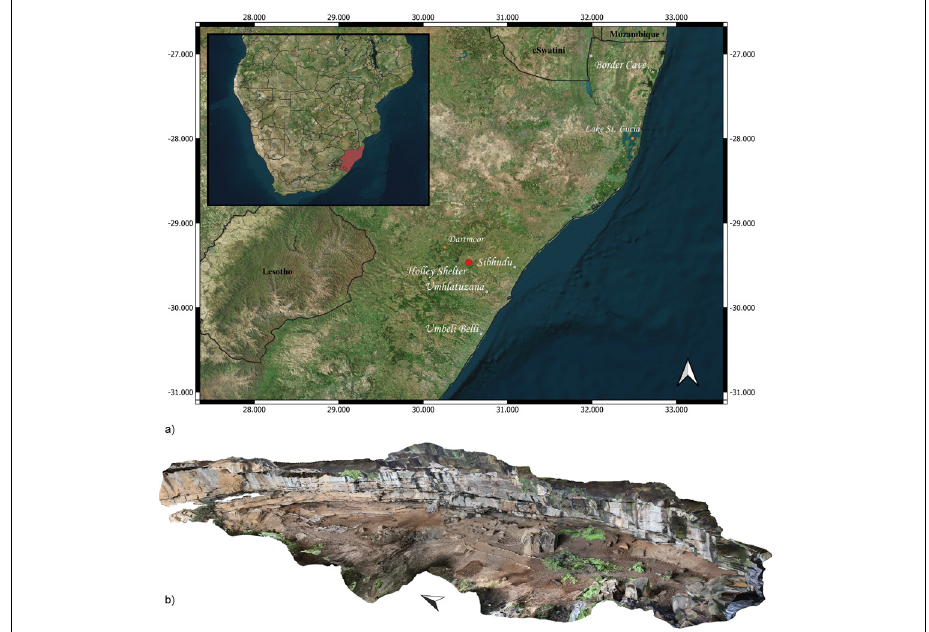
Figure 1: (a) Location of Holley Shelter and other archaeological and palaeoenvironmental sites mentioned in the text. (b) Three-dimensional model of the site produced with Agisoft Metashape Professional (by G.